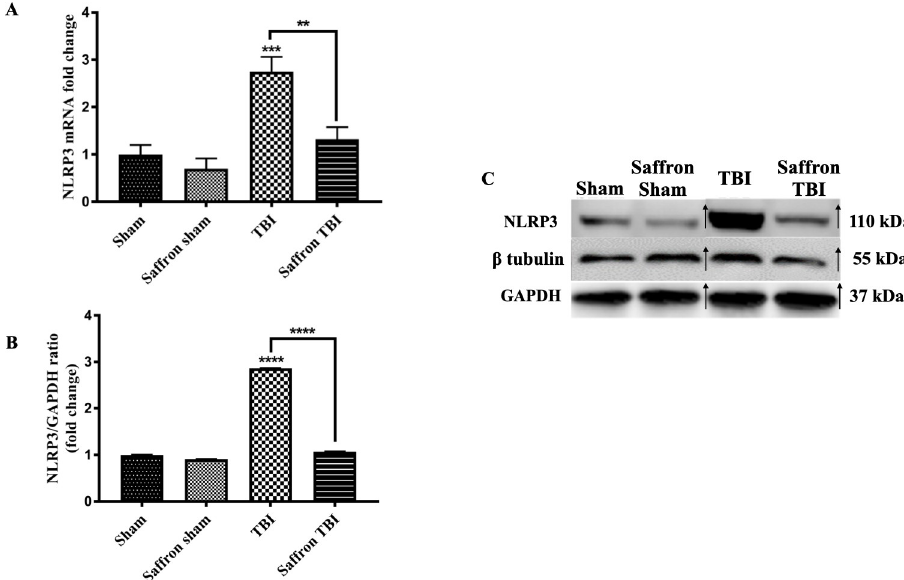
Fig 4. Effect of saffron extract on NLRP3. (A) and (B) show mRNA fold for NLRP3 and bar graphs of protein fold changes of NLRP3 to GAPDH respectively. (C) is a composite representative western blot image of bands originating from different blots of NLRP3, GAPDH, and β –tubulin. Bands of the TBI group and saffron TBI group were spliced from the same original image and re–ordered to be coherent as described in material and methods as samples were loaded differently, and with β –tubulin and GAPDH as loading controls 24hours post the final injury. The arrow signs show the spliced and rearranged bands. Data are mean ± SEM of 9 mice per group. ( �� ), ( ��� ), ( ���� ) represent P < 0.01, P < 0.001, P <